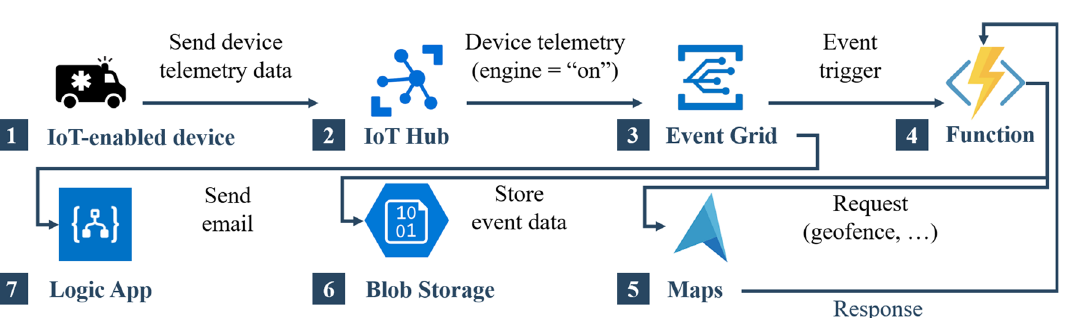
Figure 6. Incident process steps 7–8: Microsoft Azure workflow for geofencing analysis of responder vehicle to the incident site (own figure created using Microsoft PowerPoint and Azure icons 44 ). To simulate and monitor an IoT-enabled device and inform stakeholders when the vehicle approaches the incident site, the following Microsoft Azure services are required: (1) IoT-enabled device; (2) IoT Hub; (3) Event Grid; (4) Function; (5) Azure Maps; (6) Blob Storage; and (7) Logic